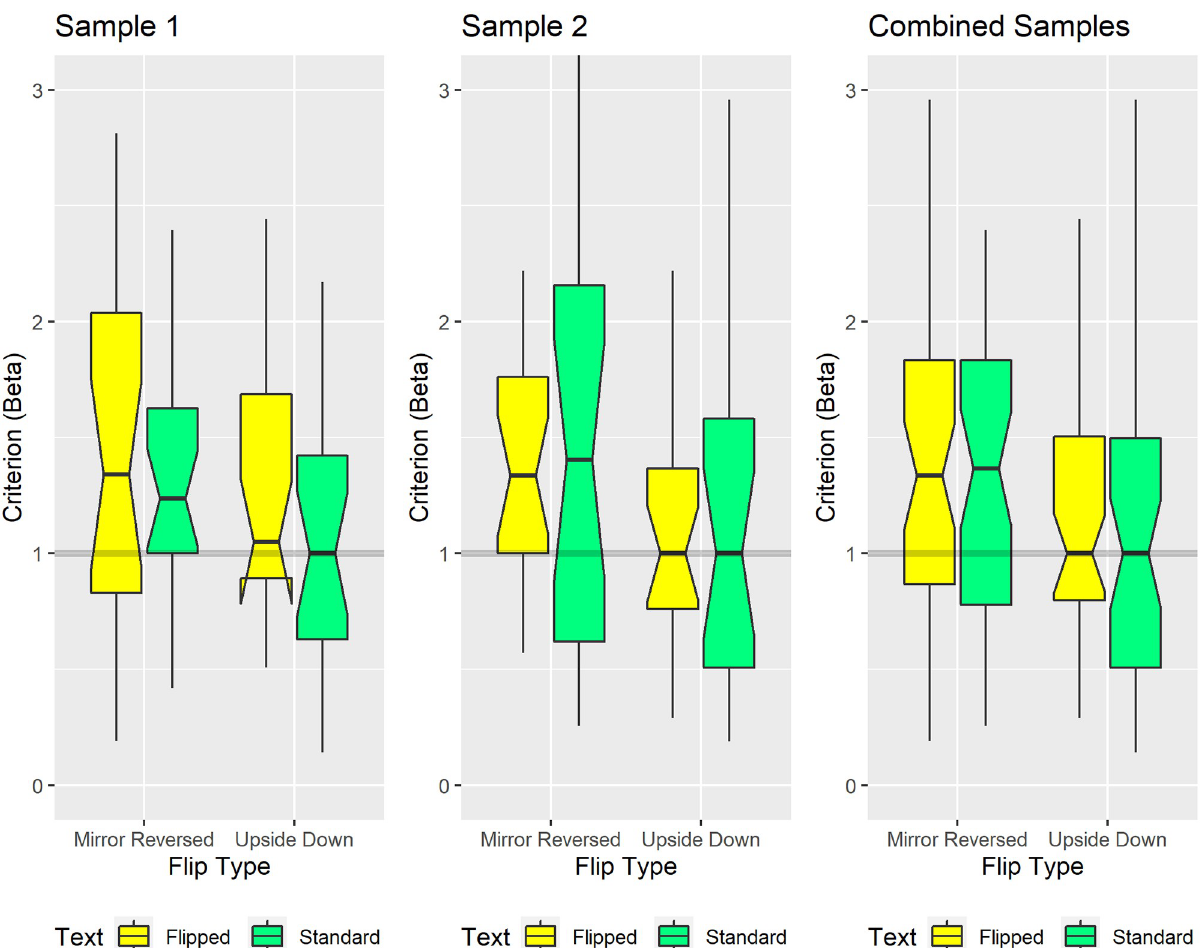
Fig 7. Biases in sentence length judgments. The gray horizontal line at 1 marks unbiased responding, i.e., equal usage of the “more-than-17-word” and “fewer-than-17-word” response options. The mirror-reversed groups exhibited a bias toward underestimating sentence length, shown by median criterion (Beta) values greater than 1. The upside-down groups judged sentence length in a relatively unbiased manner, shown by median criterion (Beta) values near or at 1. Conventions remain the same as in Fig 5. In Sample 1, the yellow box for the upside-down group’s flipped condition shows downward-pointing protrusions. This reflects a distribution skewed such that the 25th percentile falls within the median’s 95% confidence interval, i.e., within the box’s notched region [98, 99].